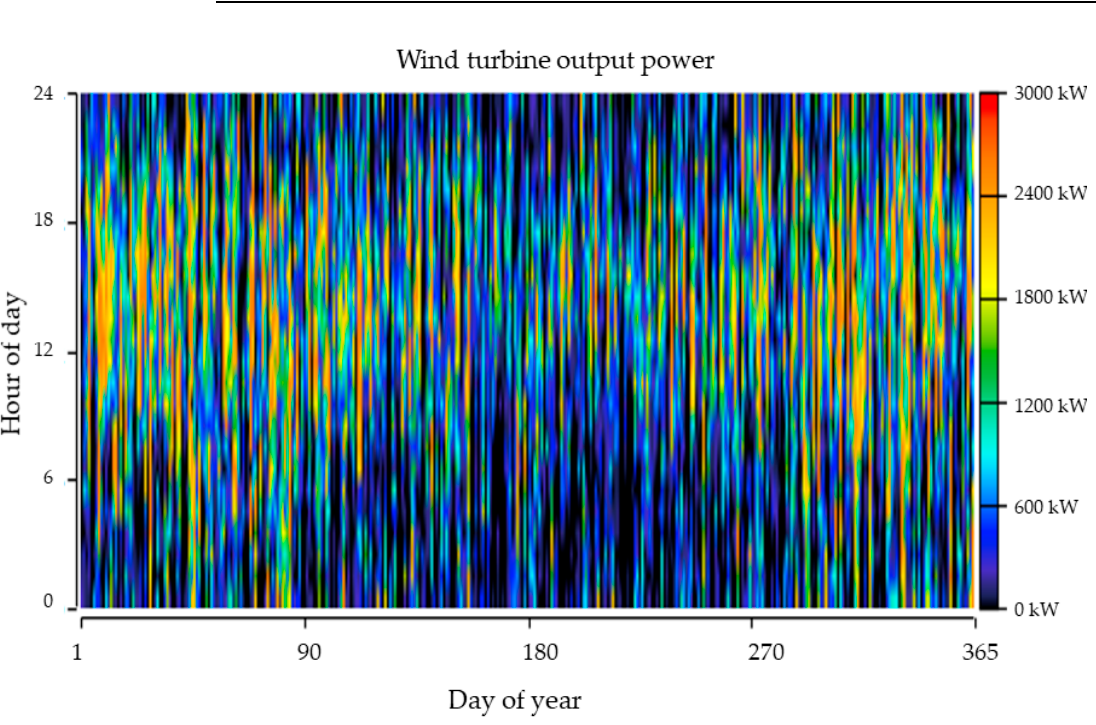
Figure 10. Annual electricity production by the wind system. Table 6. Thermal energy demand and production.